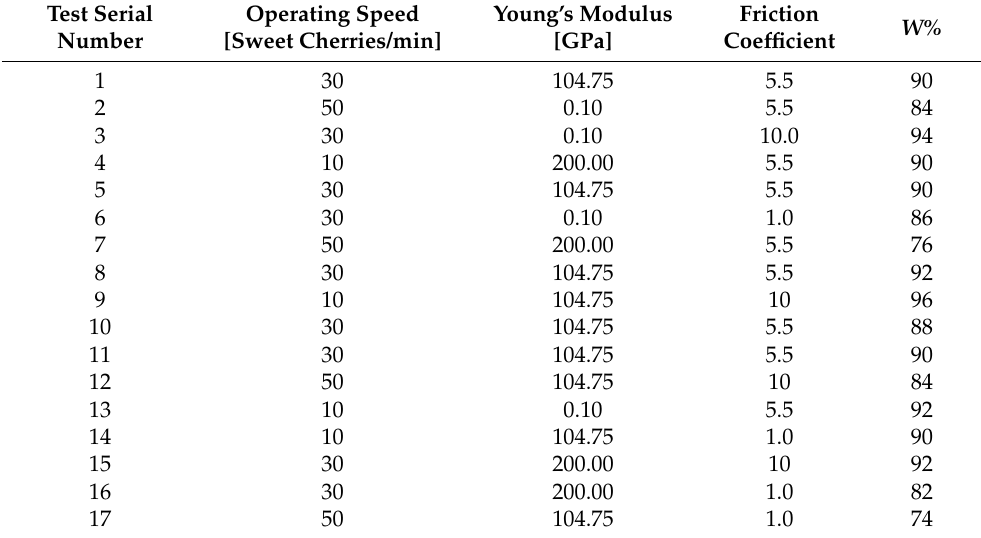
Table 3. Test design scheme and response